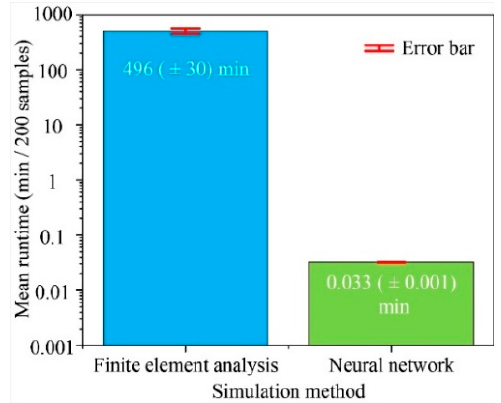
Figure 7. Runtime comparison between the traditional finite element analysis method and the neural network analyzer based on the multilayer perceptron neural network.